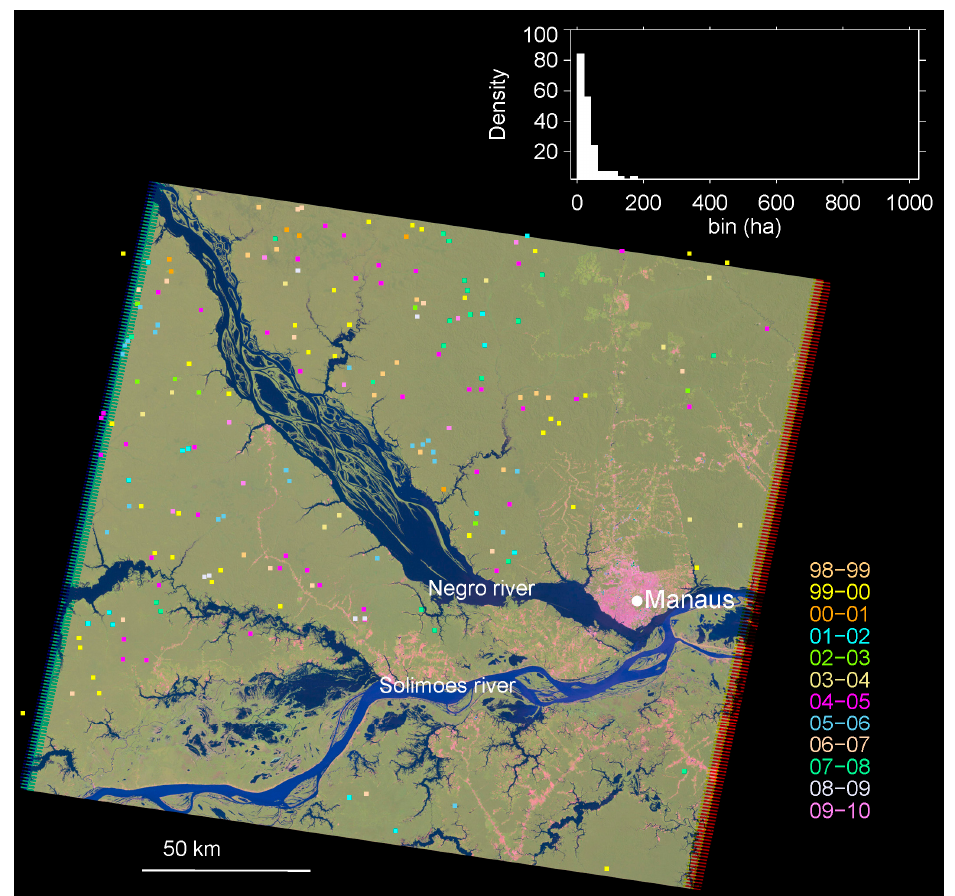
Figure 3. The spatial occurrence of windthrows in the study region over the period 1998–2010. The histogram of size frequency is shown in the top inset. The background image (L5 from 4 August 2007 was selected due to its free cloud cover condition) is shown for spatial context: blue represents water bodies, pink and light green represent anthropogenic areas, and dark green represents old- growth forest. Squares represent the centroid of windthrows with the color representing the year of their occurrence as defined in the figure legend.